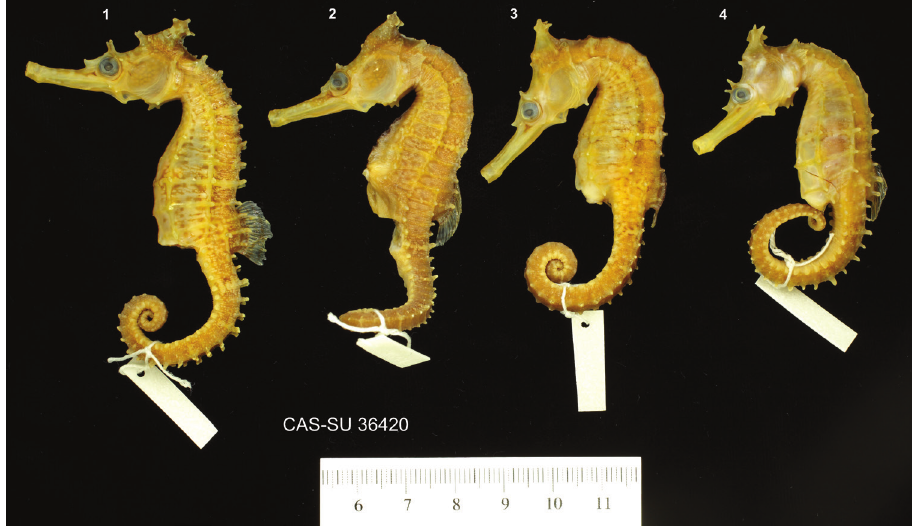
Figure 9. Hippocampus procerus , CAS-SU 36420, 4 specimens in lot, paratypes, Burnett River, Queens- land, Australia (photograph Jon